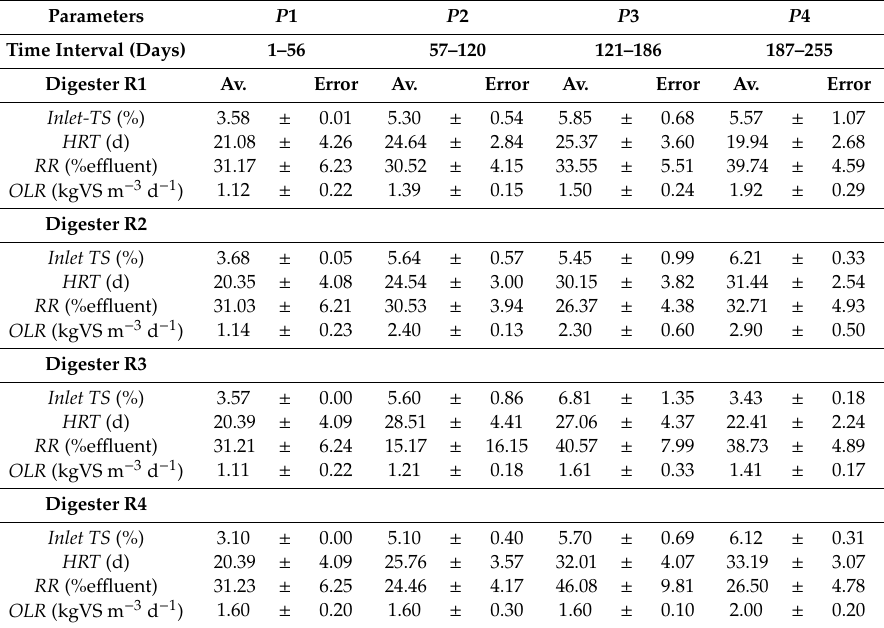
Table 2. Operational conditions. Average values ± Standard Error. Nomenclature: inlet total solids ( inlet-TS) , hydraulic retention time ( HRT ), recirculation rate ( RR ), organic loading rate ( OLR ). Abbreviations: period (P), average (Av), volatile solids